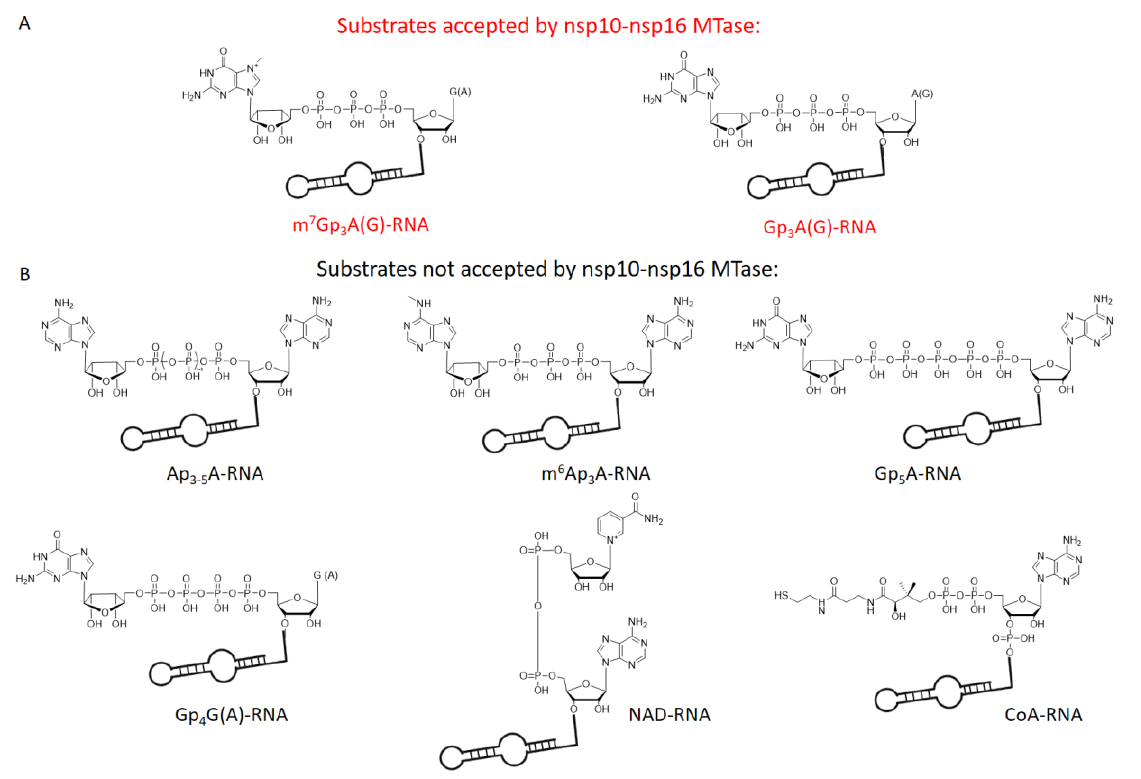
Figure 3. Chemical structures of tested capped RNAs as substrates of nsp10-nsp16 MTase. ( A ) Substrates accepted by nsp10-nsp16 MTase: m 7 Gp 3 A(G)- and Gp 3 A(G)-RNA. ( B ) Substrates not accepted by nsp10-nsp16 MTase: Ap 3-5 A-, m 6 Ap 3 A-, Gp 5 A-, Gp 4 G(A)-, NAD-, and CoA-RNA.